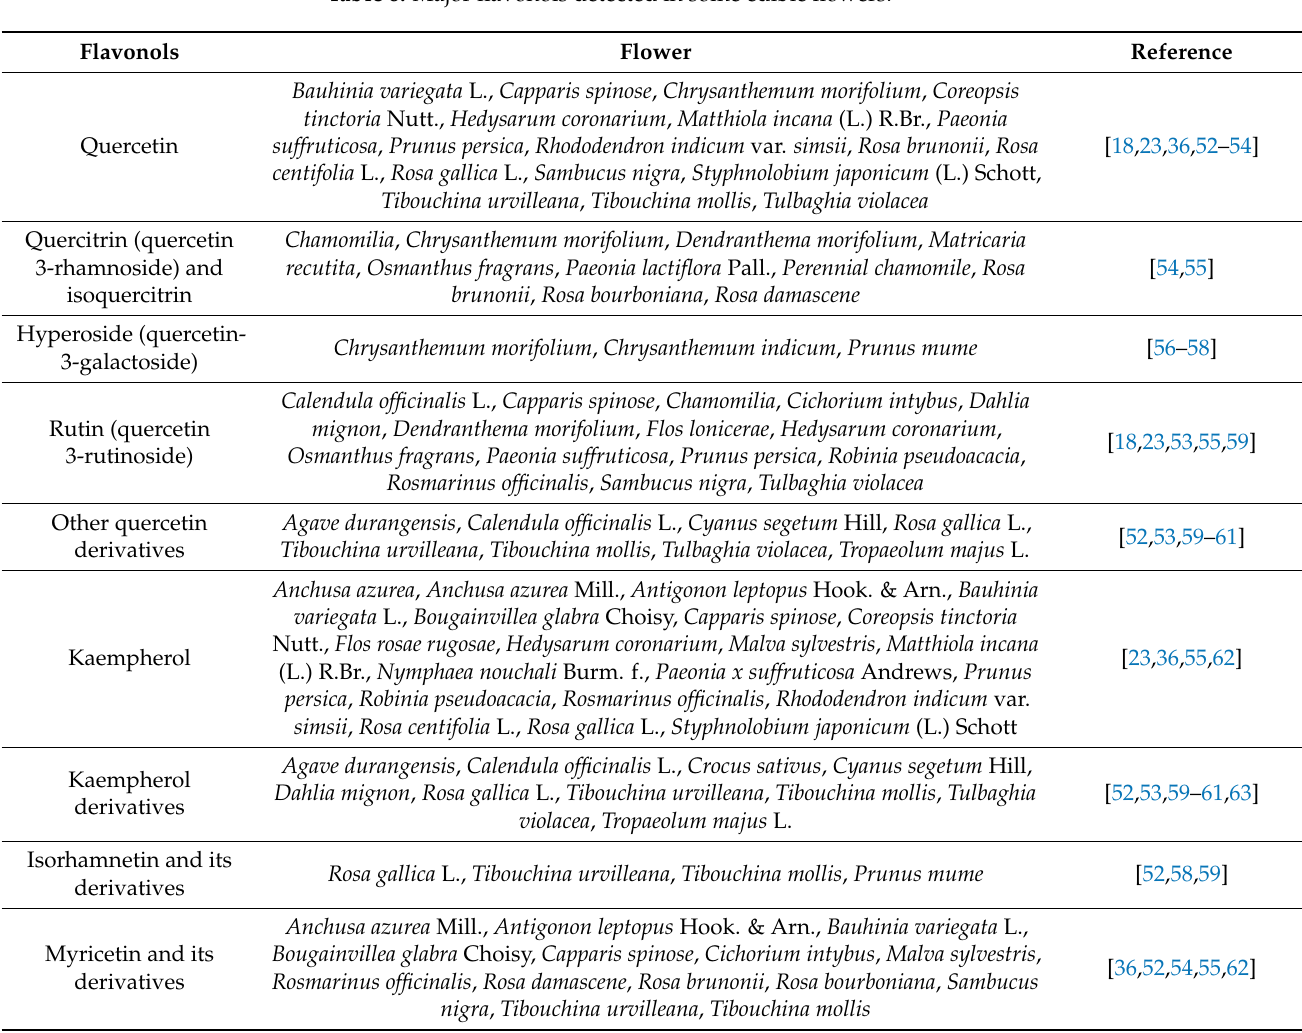
Table 8. Major flavonols detected in some edible